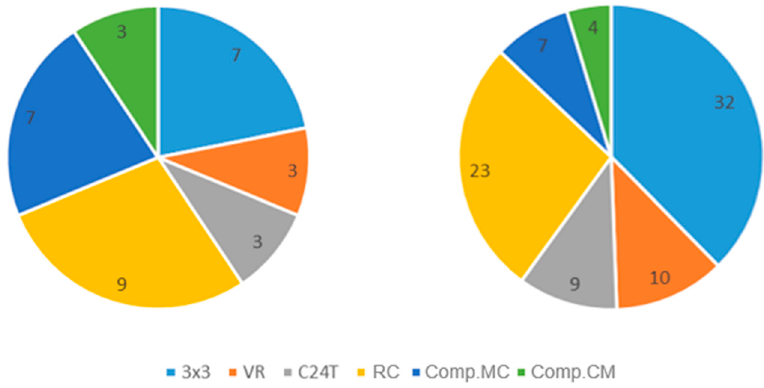
Figure 3. Total number of schools in each structural typology (total: 32 schools) (left); total number of main buildings in each structural typology (total: 85 main buildings) (right).